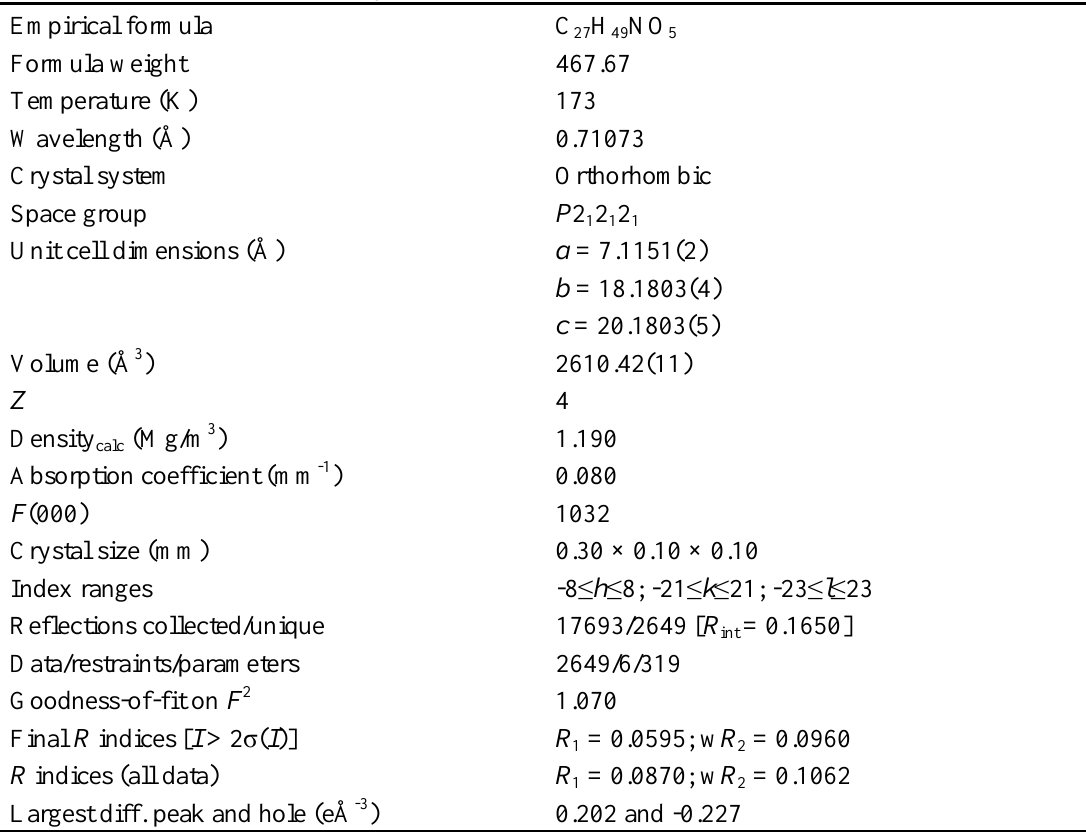
Table 6. Crystal data and structure refinement of 3